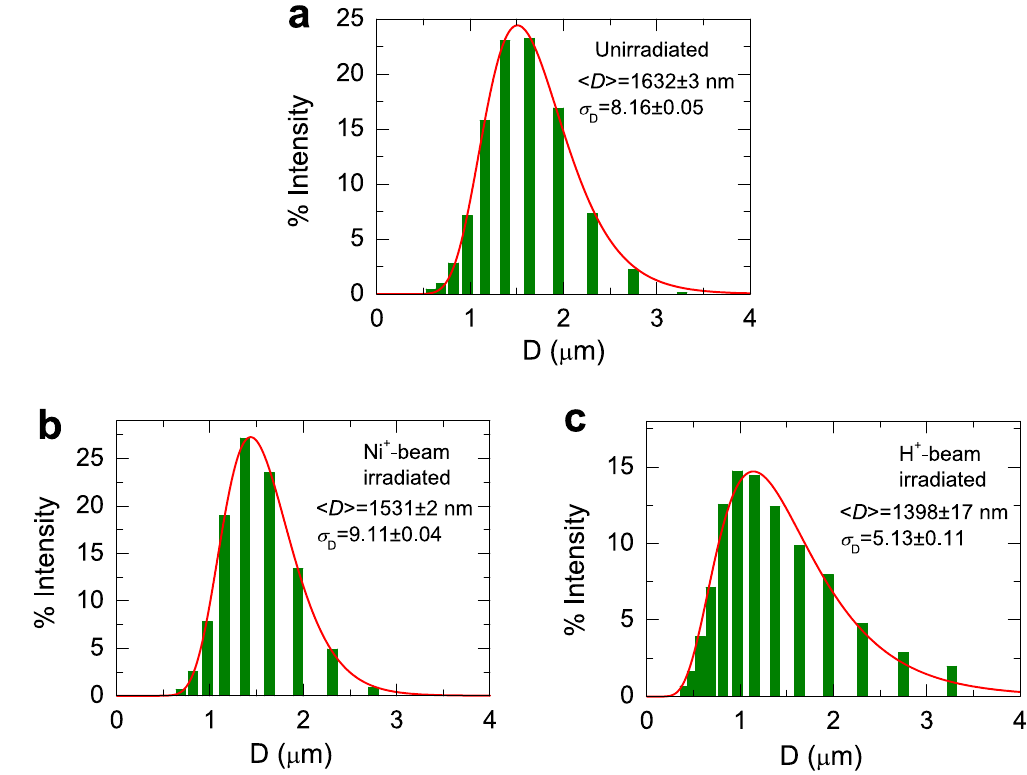
Figure 2. Particle size histograms (bars) obtained from the DLS analysis for ( a ) unirradiated, ( b ) Ni + -beam-irradiated, and ( c ) H + -beam-irradiated CI powders, and the fits of the data according to a log-normal D distribution. The fits give the median particle diameter = 1.632 ± 0.003 µ m and the distribution width σ D (cid:31) (cid:30) D = 8.16 ± 0.05 for the unirradiated sample, = 1.531 ± 0.002 µ m, σ D = 9.11 ± 0.04 for Ni + -beam-irradiated (cid:31) (cid:30) D sample , and = 1.398 ± 0.017 µ m, σ D = 5.13 ± 0.11 for the H + -beam-irradiated (cid:31) (cid:30)